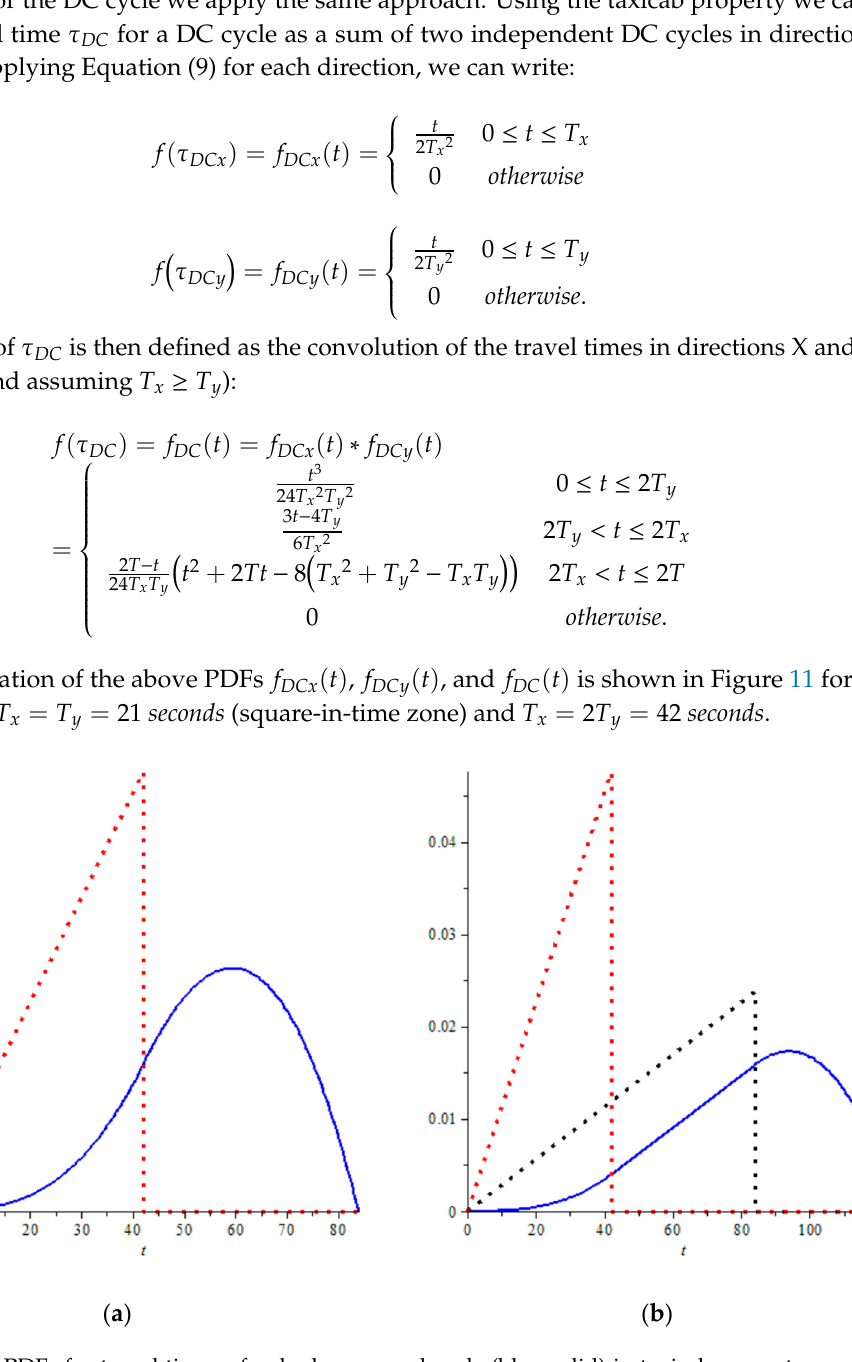
Figure 11. PDFs for travel times of a dual command cycle (blue solid) in taxicab geometry and its parts—the DC cycle in direction X (black dot) and direction Y (red dot): ( a ) in a square-in-time zone with T x = T y = 21 s ; ( b ) in a zone with T x = 2 T y = 42 s .